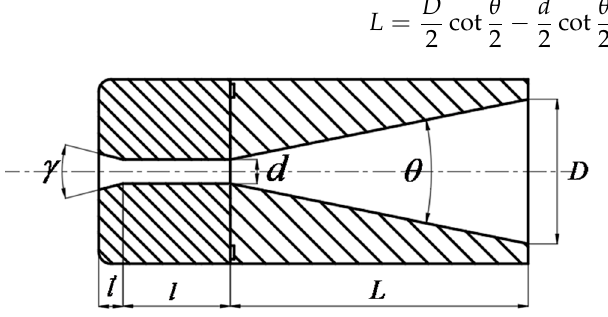
Figure 2. Diagram of the nozzle structure.